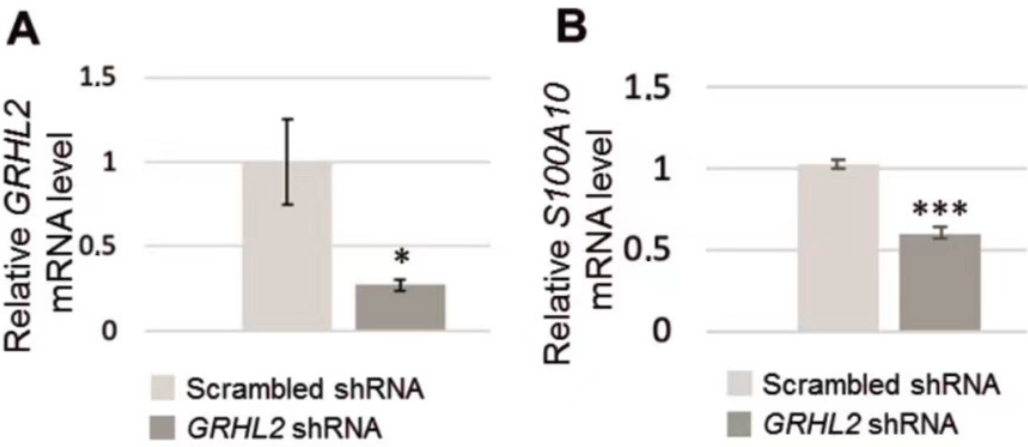
Figure 4. S100A10 mRNA in RC-124 cells with silenced GRHL2 . ( A , B ) RT-qPCR analysis showing the level of GRHL2 mRNA and S100A10 mRNA, respectively. ( A , B ): statistical analysis of results obtained from n = 3 experiments was performed with the use of Student’s t -test. Results are presented as means ± standard deviation. The level of statistical significance is indicated using * p ≤ 0.05 or *** p ≤ 0.001. Scrambled shRNA represents control cells while GRHL2 shRNA—cells with silenced GRHL2 expression.